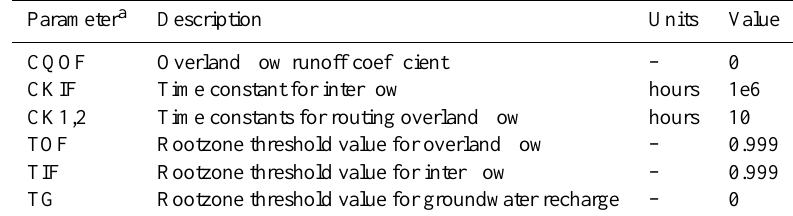
Table 1. NAM parameters chosen to enforce the rainfall-runoff model structure shown in Fig. 3.